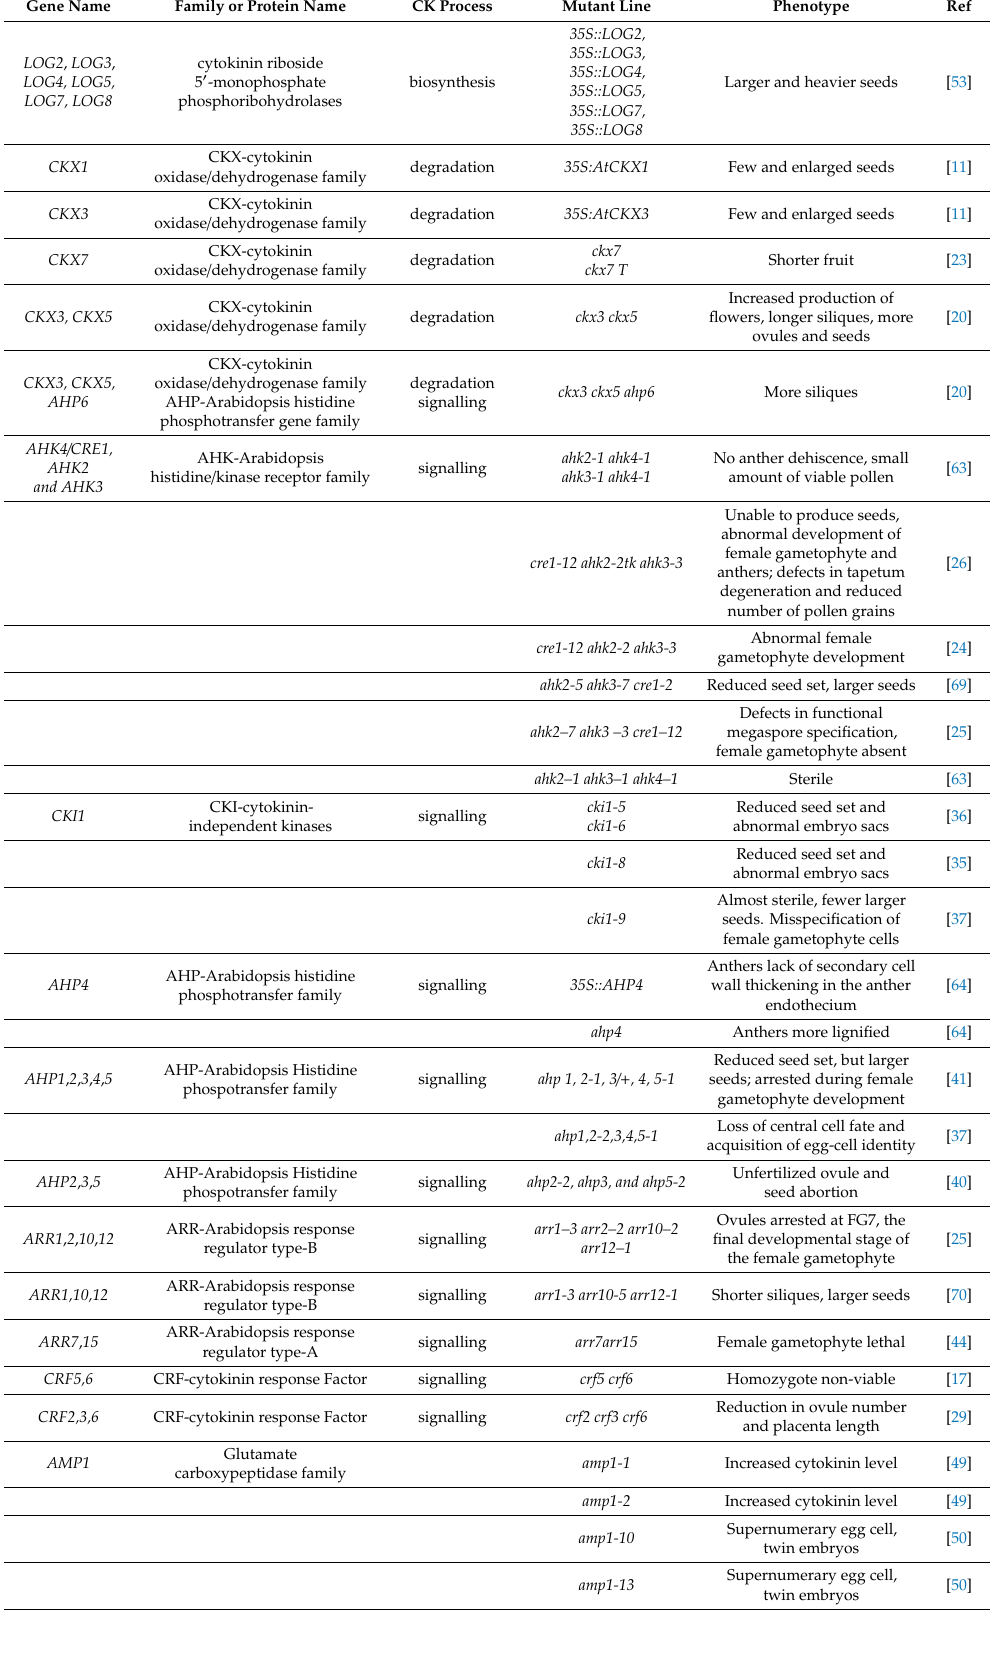
Table 1. Cytokinin-related mutants with reproductive development defects in